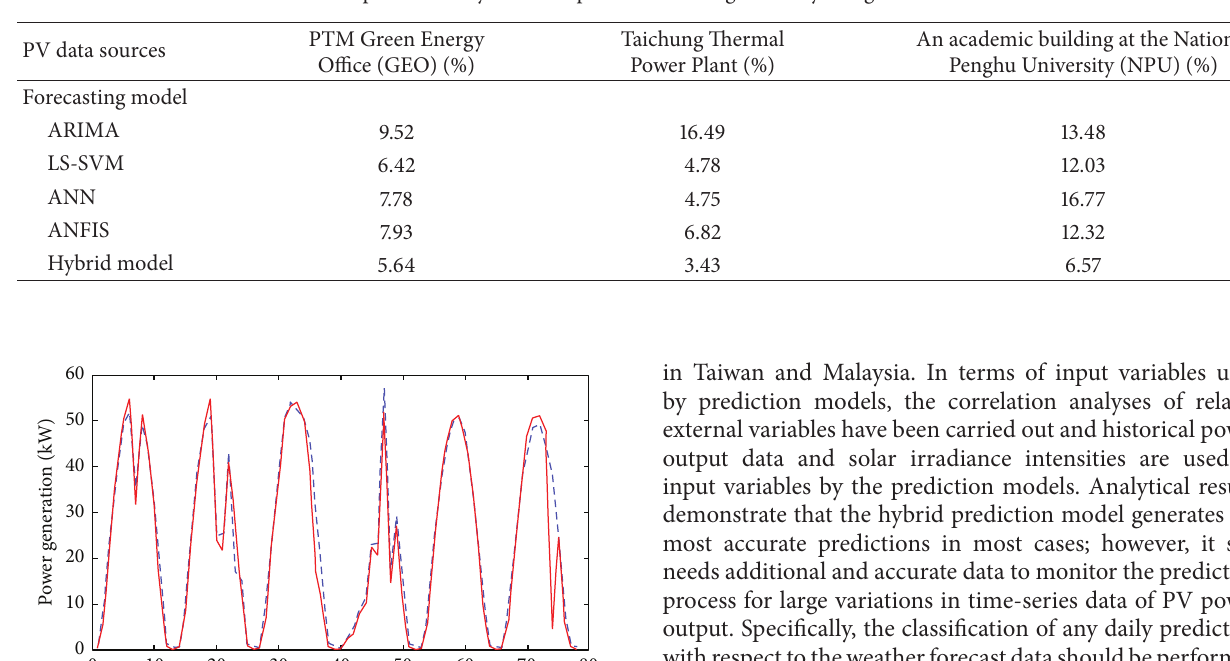
Table 3: Comparative analysis on PV power forecasting errors by using different methods.